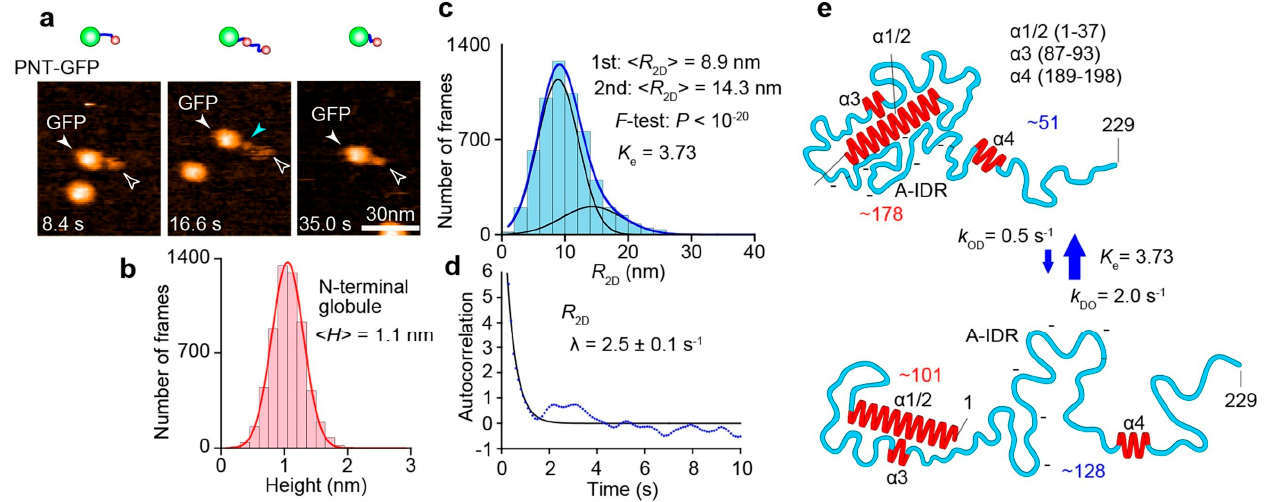
Figure 6. HS-AFM analysis of structure and dynamics of PNT. ( a ) HS-AFM images and their schemat- ics of PNT-GFP. The open arrowheads point to the N-terminal globule of PNT, while the light-blue arrowhead points to a small globule appeared in the middle of disordered region (very likely corre- sponding to α 4). ( b ) Height distribution of the N-terminal globule. The value 1.1 nm is identical to the diameter of a single α -helix. ( c ) Distribution of end-to-end distance of fully disordered IDR ( R 2D ). ( d ) Autocorrelation function of time-series data of R 2D . The value of λ represents the decay constant of the autocorrelation function. ( e ) Schematics showing structural and dynamic features of PNT. The top and bottom panels correspond to the more- and less-ordered states, respectively. The numbers in red and blue represent the numbers of amino acids contained in the respective globules and fully disordered IDRs, respectively, estimated by using the power law and measured (cid:104) R 2D (cid:105) values. The blue arrows indicate the kinetic nature of changes in R 2D